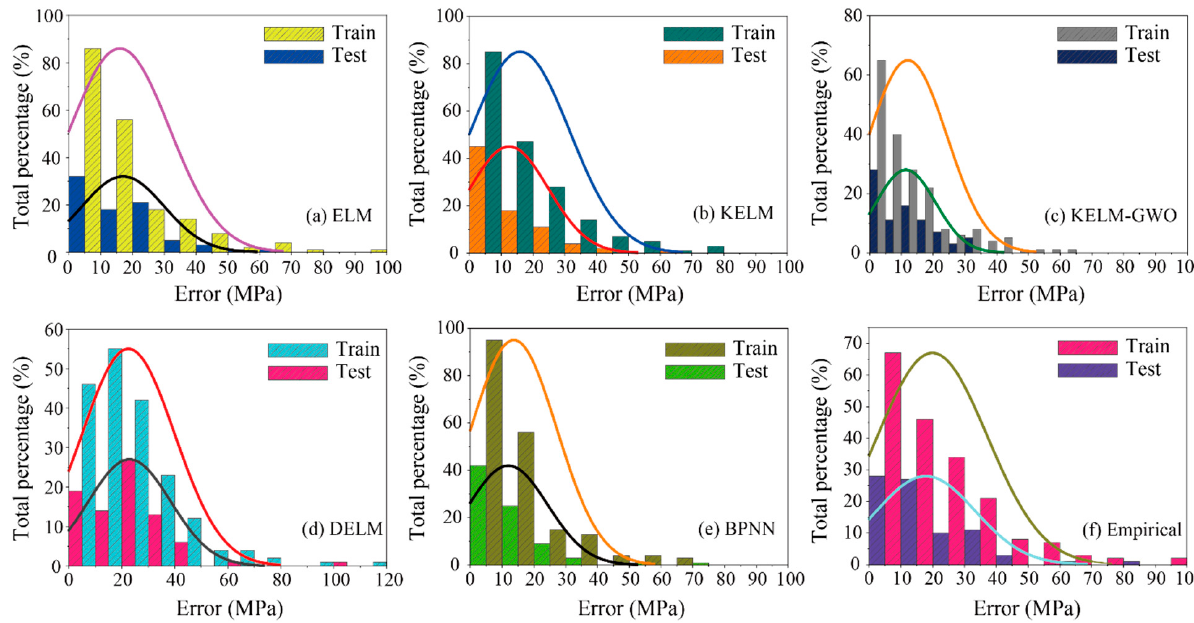
Figure 10. Illustration of error histogram in the training and testing phases